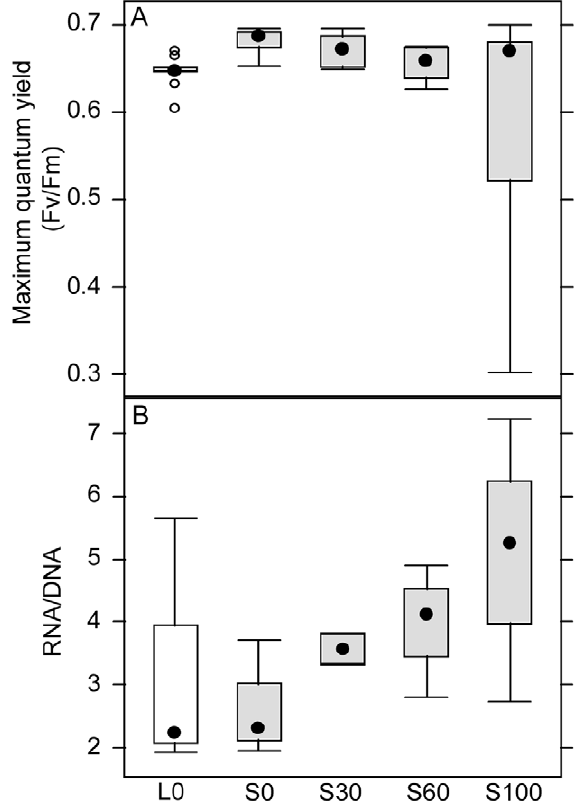
Figure 4. The effects of macroalgae on maximum quantum yield and RNA/DNA ratio of corals in the laboratory experi- ment. (A) Maximum quantum yield (Fv/Fm) and (B) RNA/DNA ratio in nubbins of the coral Acropora millepora after 10 days of exposure to microenvironments simulating conditions underneath macroalgal assemblages. Data are untransformed means 6 SE (n=9; and n=6 in the S100 treatment).